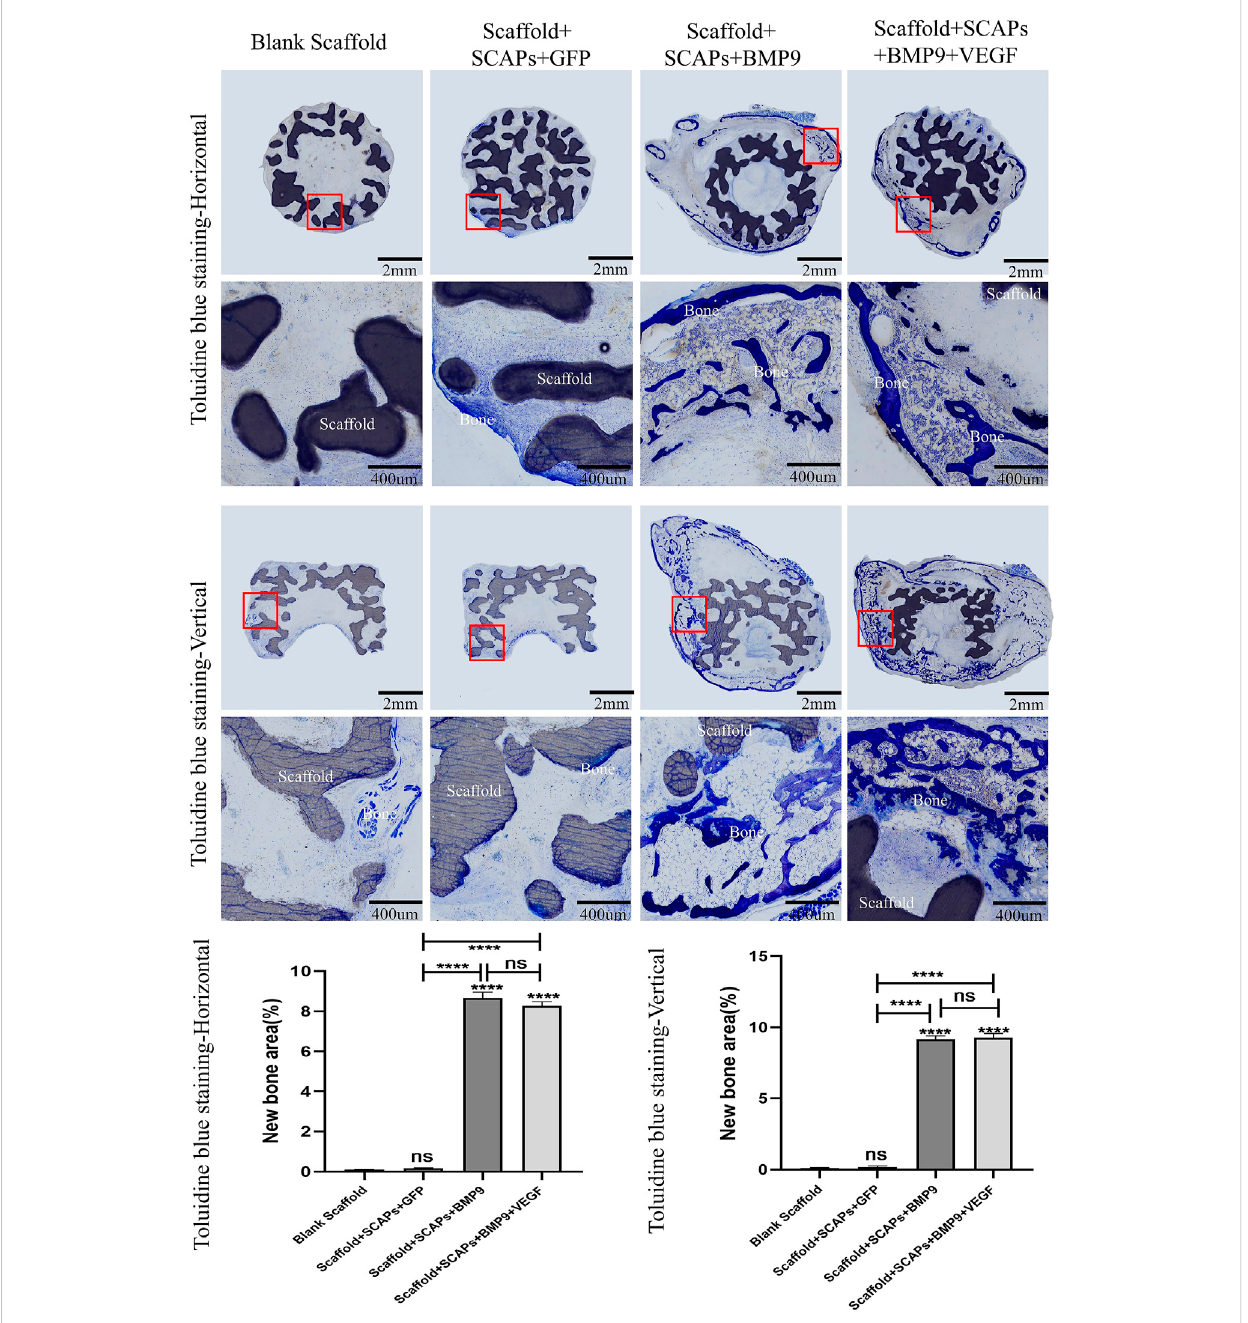
FIGURE 8 Histological analysis of bioceramic scaffolds implanted subcutaneously in nude mice after 2 months (Toluidine blue staining).